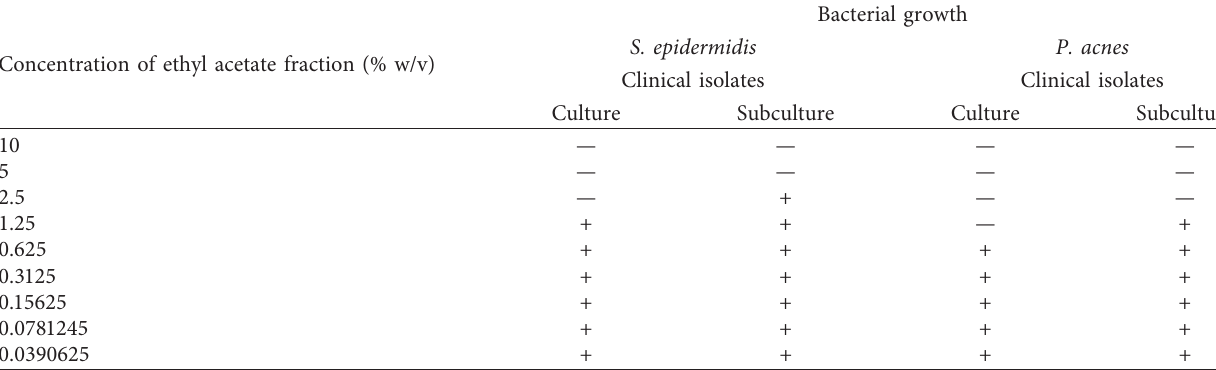
Table 6: MIC and MBC ethyl acetate fraction of cassava